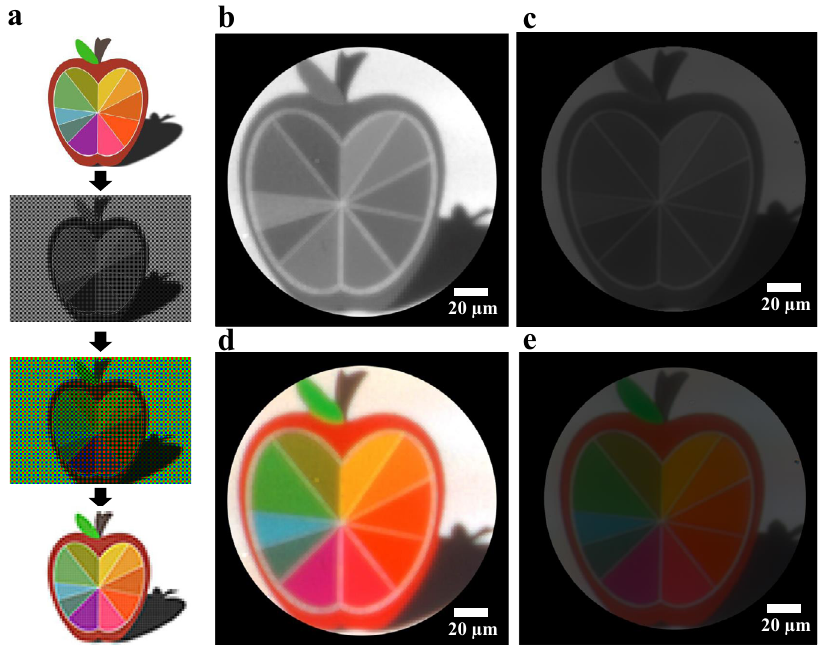
Fig. 4 Comparison of imaging response between MBCR and BCFs. a The postprocessing procedure of colour imaging. b , c Greyscale images were obtained directly by reconstructing the monochromatic images obtained using MBCR and BCFs respectively, for comparison of the intensity. d , e The reconstructed colour images of MBCR and BCFs combined with the spectral response,